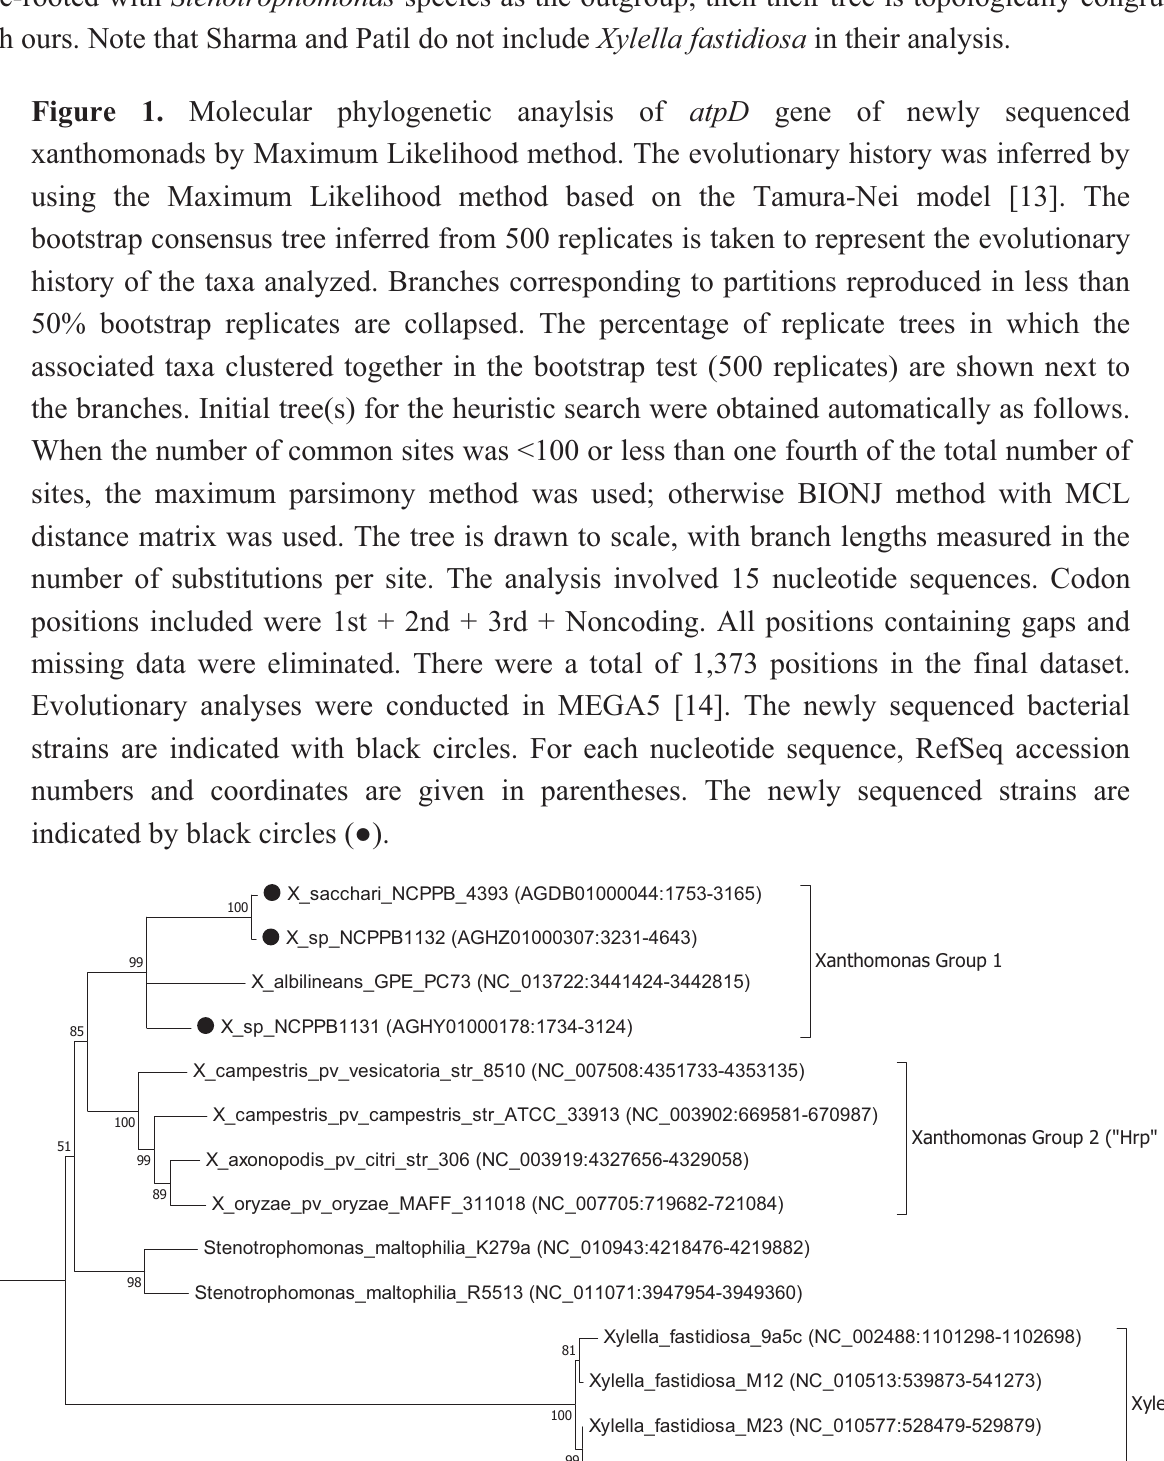
Figure 1. Molecular phylogenetic anaylsis of atpD gene of newly